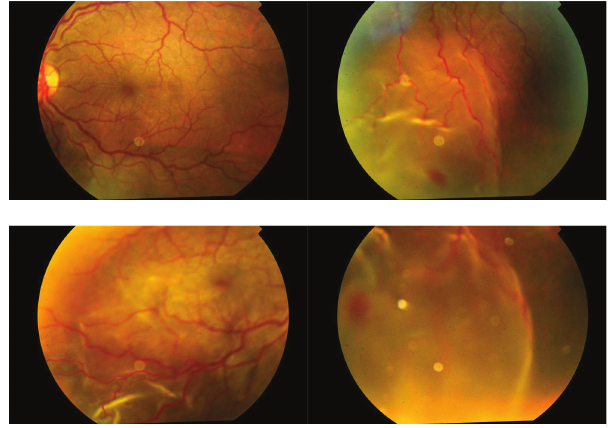
Figure 3. Fundus photograph of both eyes showing choroidal folds at the macula, retinal hemorrhages, and serous retinal detachment.